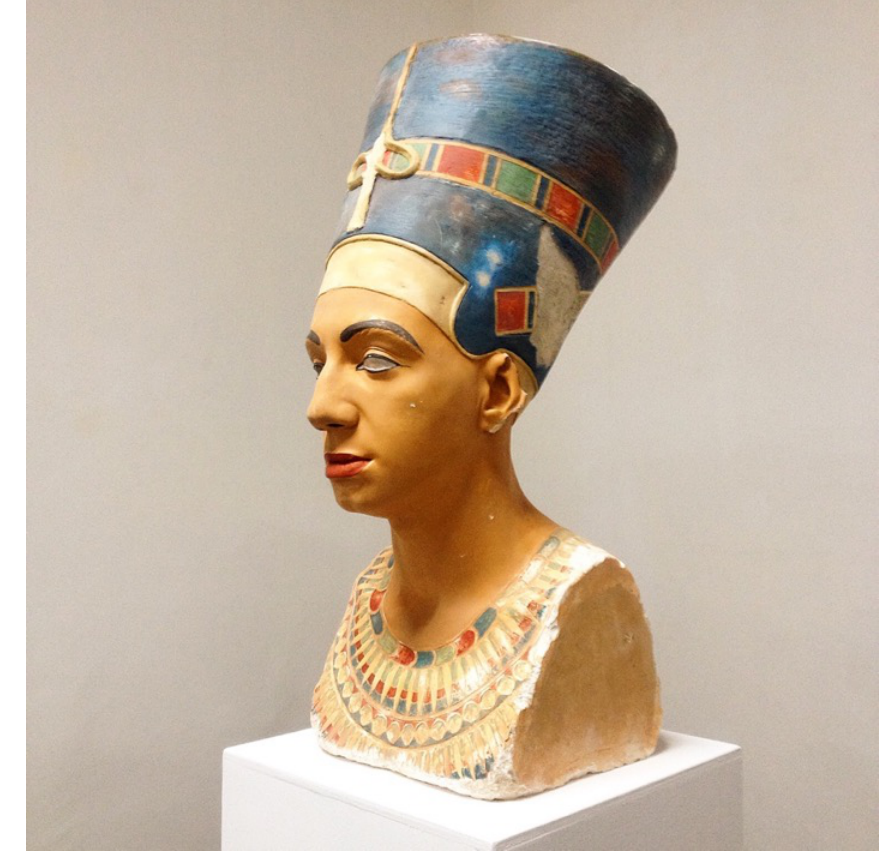
Figure 5 Mehdi-Georges Lahlou, I Used to be Nefertiti , 2014. Plaster, gesomonite, polystyrene, and paint. +/- 60 by 24 x 45 centimeters, unique. Image courtesy of the artist and Galerie Transit, Mechelen,